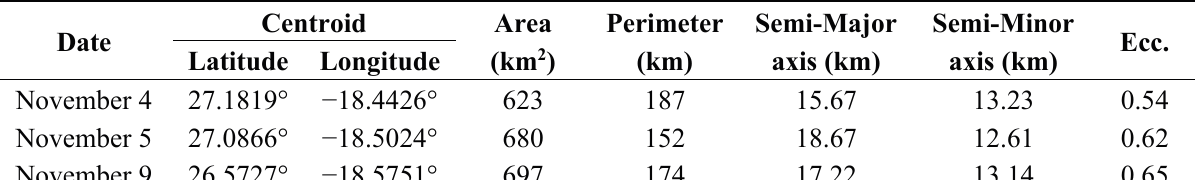
Table 1. Extracted Parameters Describing the Eddy at Different Dates.